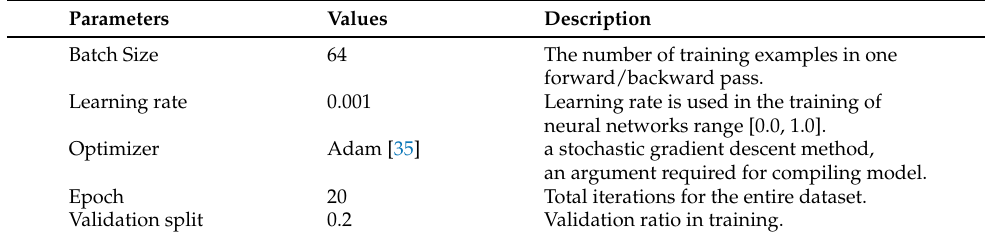
Table 4. Training hyper-parameters (both autoencoder and MLP classifier). Parameters